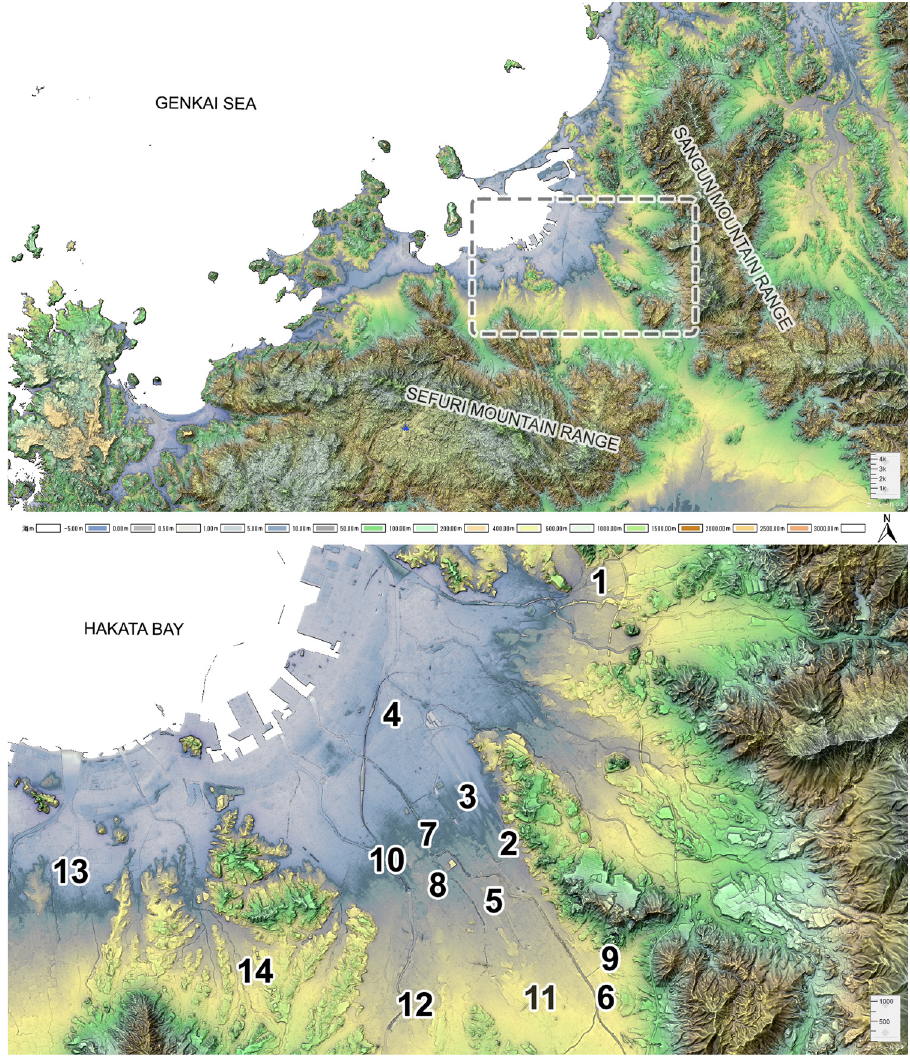
Figure 4: The Hakata Bay region, Kyushu Island, Japan, with overlaid sites utilized in this study ( 1 – 14 ) .